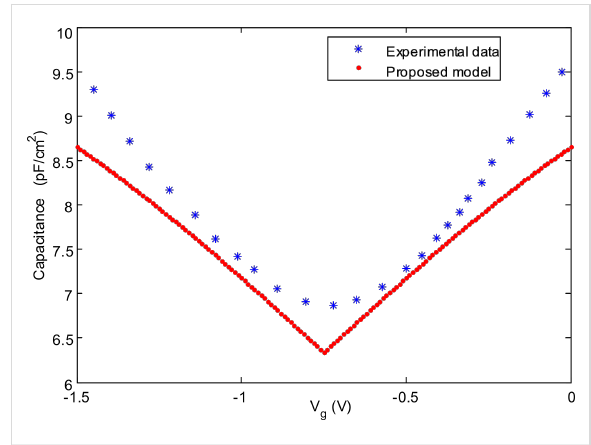
Figure 3: The proposed model of quantum capacitance of EGFETs based single-layer